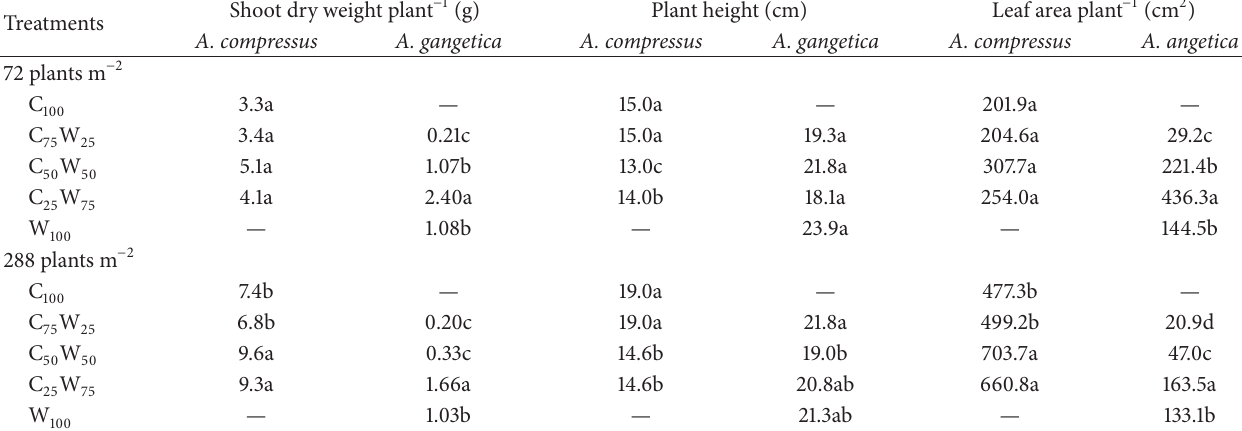
Table 2: Shoot dry weight, plant height, and leaf area of A. compressus and A. gangetica in monoculture and mixtures at 10wk after planting in shade.